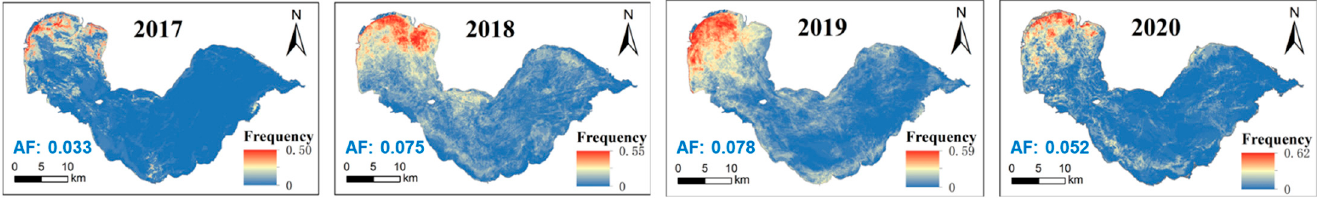
Figure 12. Temporal change and spatial distribution map of CyanoHABs frequency in Chaohu Lake from 2017 to 2020. Data for 2016 was excluded as there were too few images.